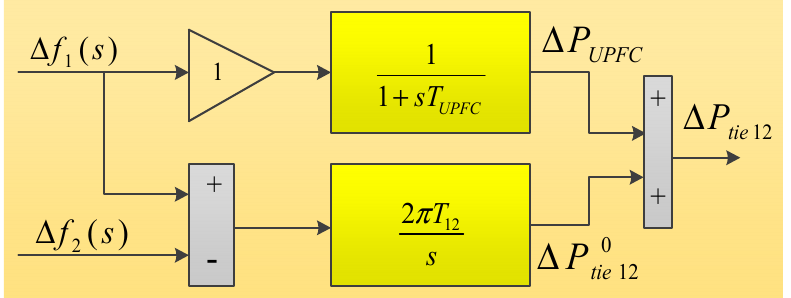
Figure 5. UPFC damping controller [21].